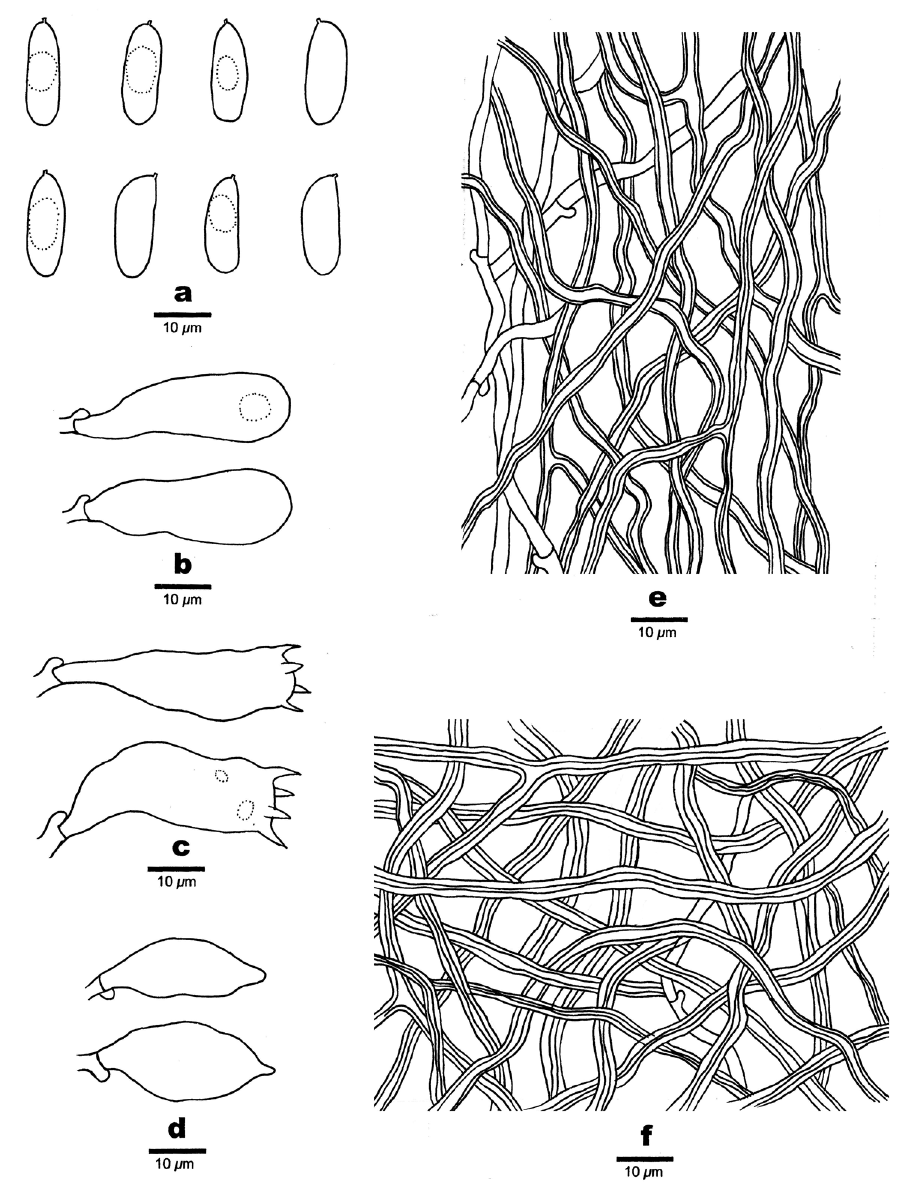
Figure 4. Microscopic structures of Megasporia yunnanensis sp. nov. (drawn from the holotype). a Basidi- ospores b Basidioles c Basidia d Cystidioles e Hyphae from trama f Hyphae from subiculum. white to cream but with brownish tints when dry; pores round, 2–3 per mm; dissepi- ments thin, lacerate. Subiculum white, corky, up to 1 mm thick. Tubes cream, corky, up to 1 mm